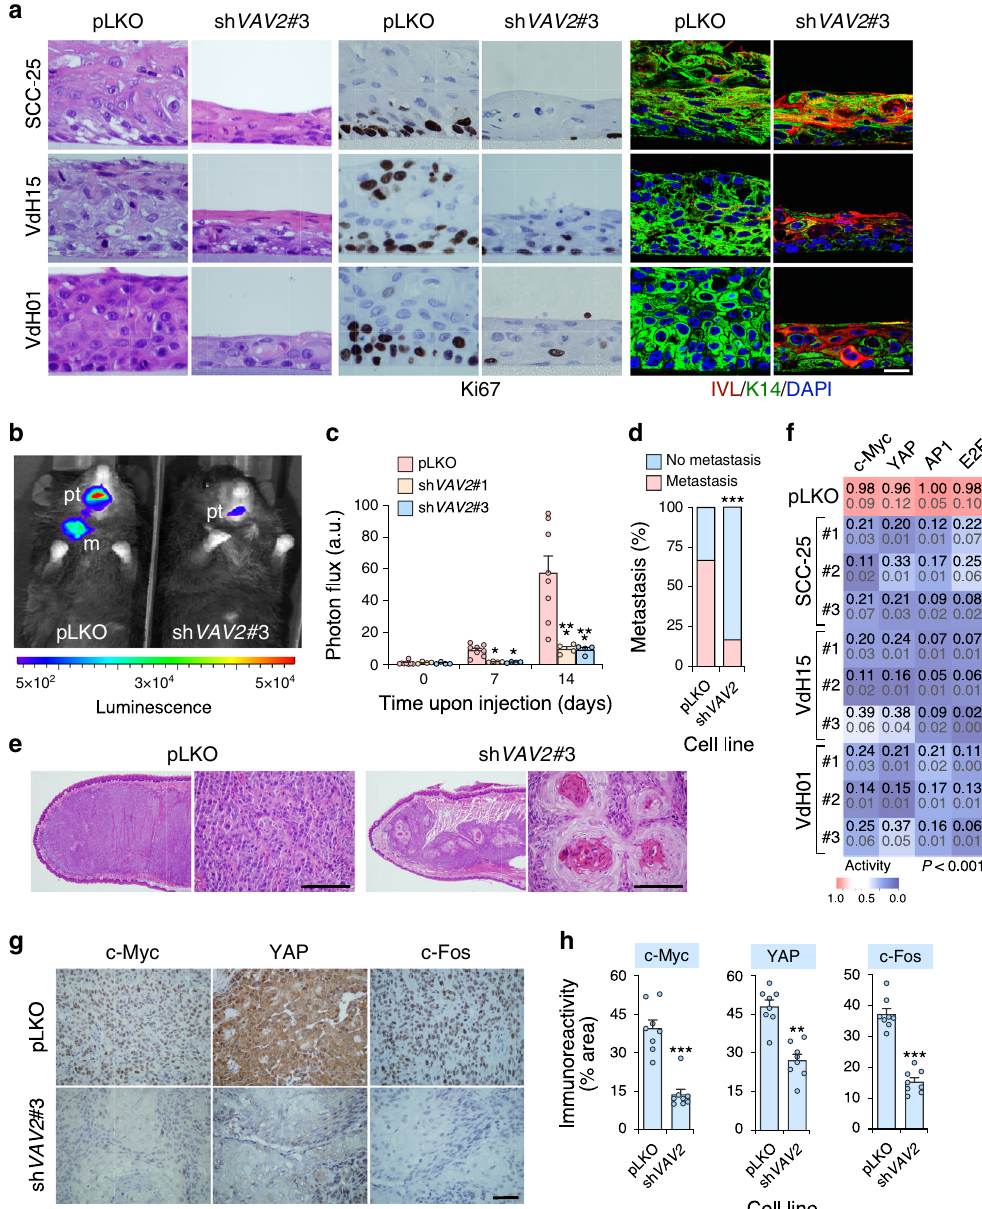
Fig. 9 Endogenous VAV2 is required for the fi tness of hnSCC cells. a Images of sections from organotypic cultures of the indicated control (pLKO) and VAV2 knockdown (sh VAV2 ) cell lines upon staining with hematoxylin-eosin (two left columns of panels) and antibodies to Ki67 (two middle columns of panels), IVL and K14 (two right columns of panels). Some of the sections were counterstained with either hematoxylin (two middle columns of panels) or DAPI (two right columns of panels, blue color). The speci fi c cell line and experimental modi fi cation used is shown on the left and top, respectively. pLKO, cells transduced with an empty lentivirus. shVAV2#3, cells transduced with a lentivirus encoding the VAV2 shRNA #3. The same notation will be used in the rest of panels of this fi gure. Scale bar, 10 μ m ( n = 5 independent cultures). b Luminescence readings at the endpoint of the tongue orthotopic xenograft experiment using the indicated VdH15 cells ( n = 8 per cell type derivative). pt, primary tumor; m, metastasis. c Photon fl ux of the indicated xenografted animals according to data from panel b. Data represent the mean ± SEM. * P = 0.010 and 0.012, respectively (day 7); *** P < 0.0001 (day 14) (Kruskal – Wallis test, n = 8). d Lymph node metastatic events detected in animals used in panel b. Data represent percentage. *** P < 0.0001 (Chi-squared test, n = 8). e Histological sections of the SCC tumors formed by the indicated VdH15 cells in the experiments shown in b . Scale bar, 75 μ m ( n = 8 per cell type derivative). f Luciferase activity recorded in the indicated cells (left) upon transient transfection with plasmids encoding the luciferase gene under the regulation of promoters regulated by the indicated transcriptional factors (top). For each condition, the mean and the SEM are indicated in black and gray, respectively. The color gradient is proportional to the level of inhibition achieved when compared to control cells (whose values are shown in red). #1, #2 and #3 (left) refer to the independent shRNAs used to knockdown endogenous VAV2 . For all of them, P < 0.001 (ANOVA and Dunnett ’ s multiple comparison test, n = 3 independent experiments). g Expression of indicated proteins (top) in tumors formed in the experiment shown in b . Scale bar, 50 μ m ( n = 8). h Quanti fi cation of immunohistochemical data from g . ** P = 0.001; *** P < 0.0001 (two-tailed Student ’ s t -test, n = 8). Data represent the mean ± SEM. Source data for this fi gure are provided as a Source Data fi